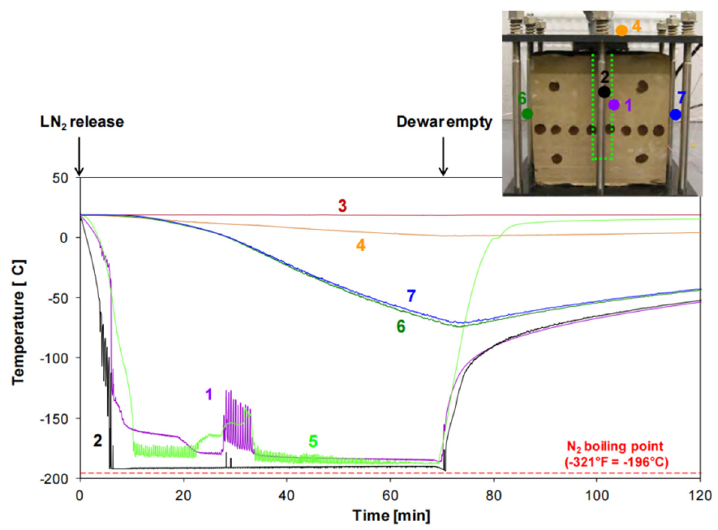
Figure 6. Temperature versus time during the unconfined low-pressure LN2 test. The sample picture (top right of the figure) is where the thermocouples were located on the sample (from Cha et al. 16).